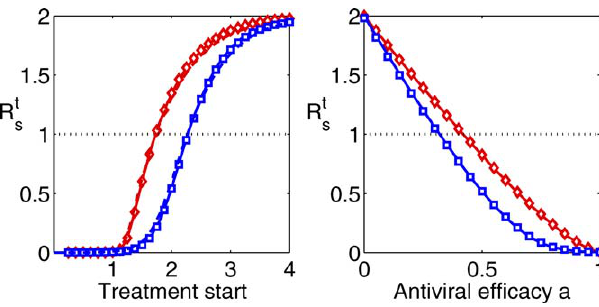
Figure 8. R t as a Function of Treatment Start and Antiviral Efficacy s Unless varied, treatment starts 24 h post-infection, and antiviral efficacy is a ¼ 0.99/0.97. Red = TD model, blue = IR